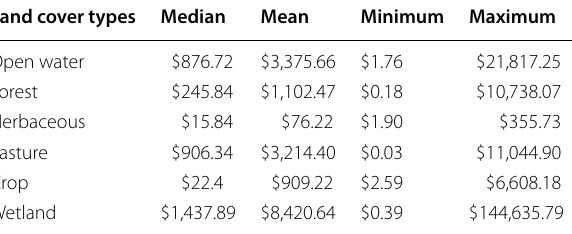
Table 2 Economic values ($/acre/year) for each land